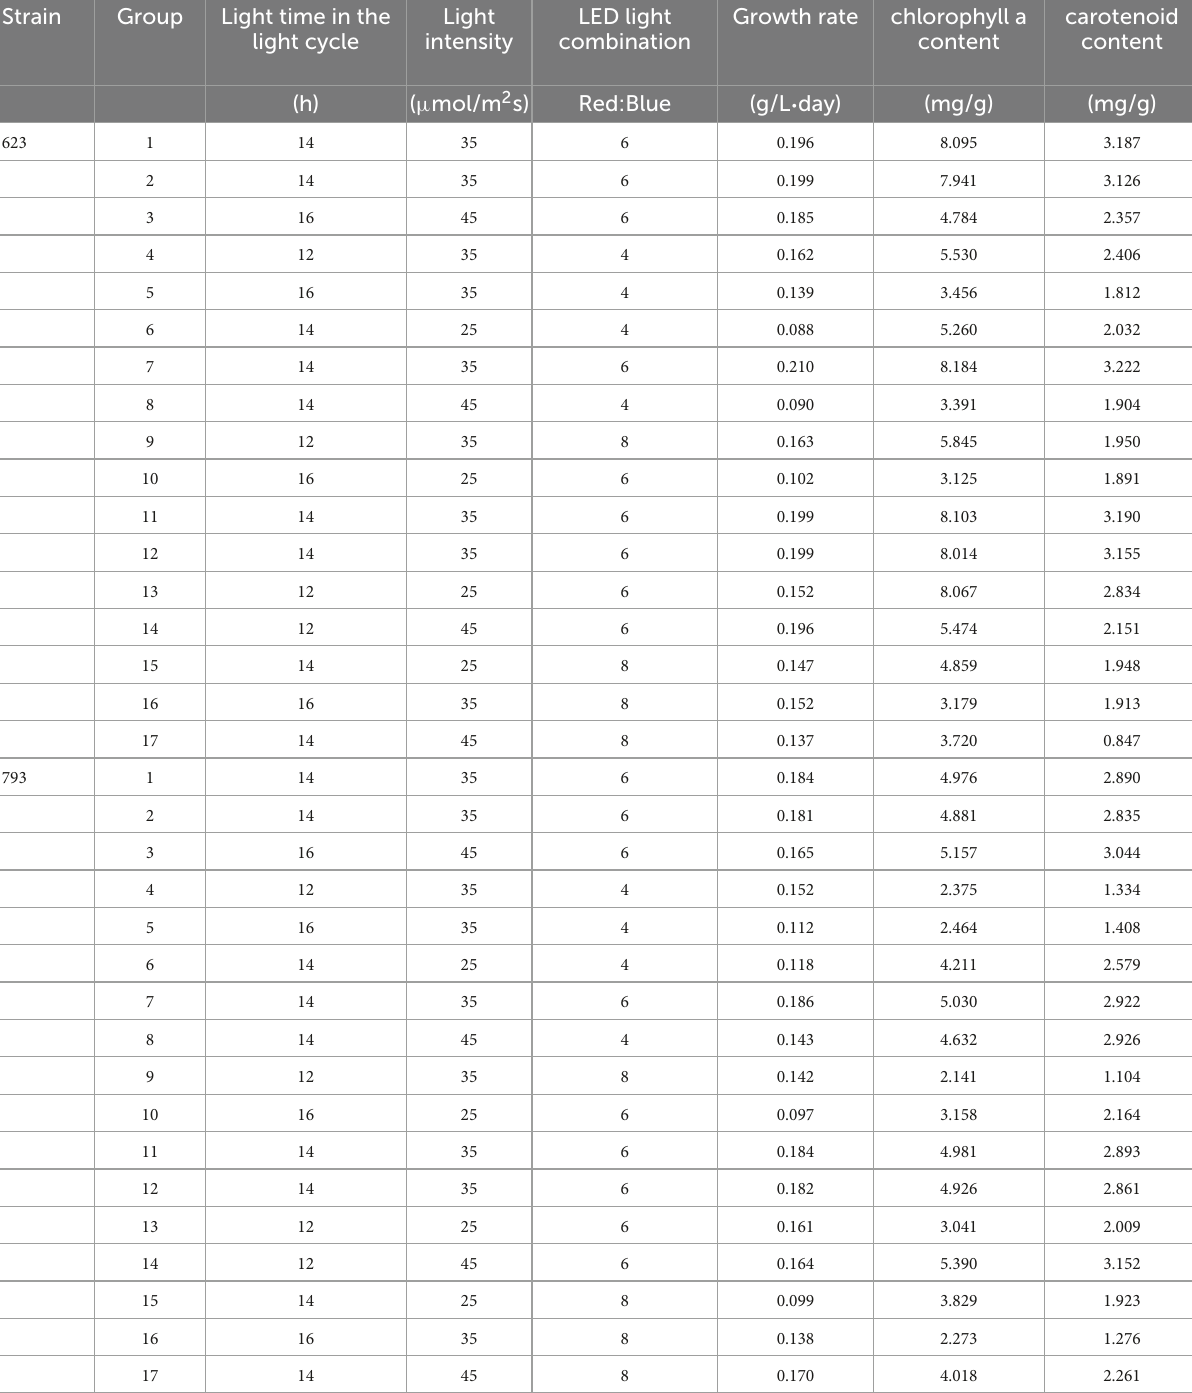
blue8: red1) were selected. The growth rate, pigment content, protein content, phycocyanin content and polysaccharide content of A. platensis OUC623 and A. platensis OUC793 were used as the response values, and the response